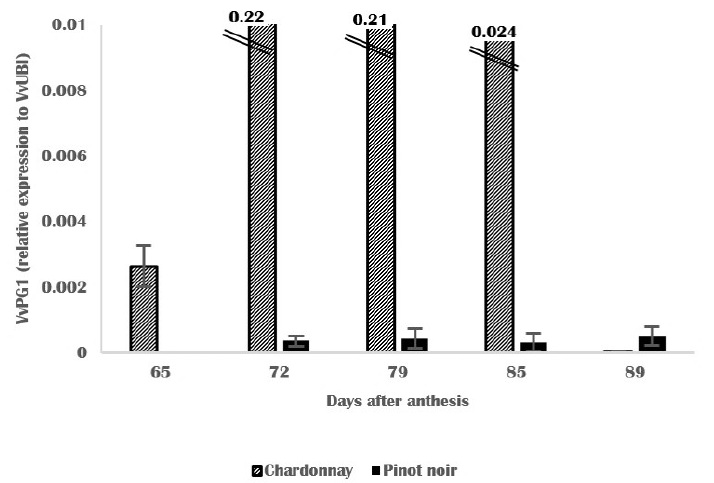
Figure 11. Gene expression of VvPG1 in Pinot noir and Chardonnay skins during ripening. Means of 3 replications ±